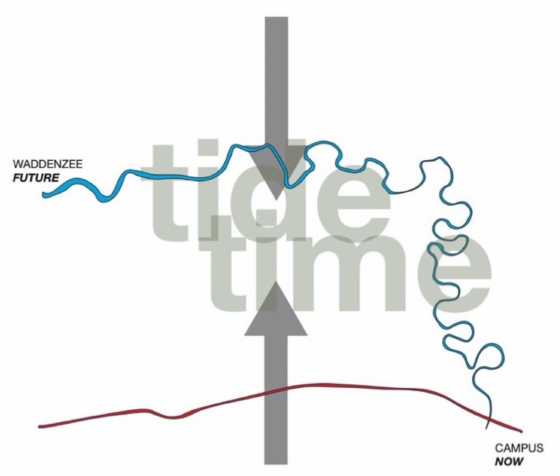
Figure 6. Balance between tide and